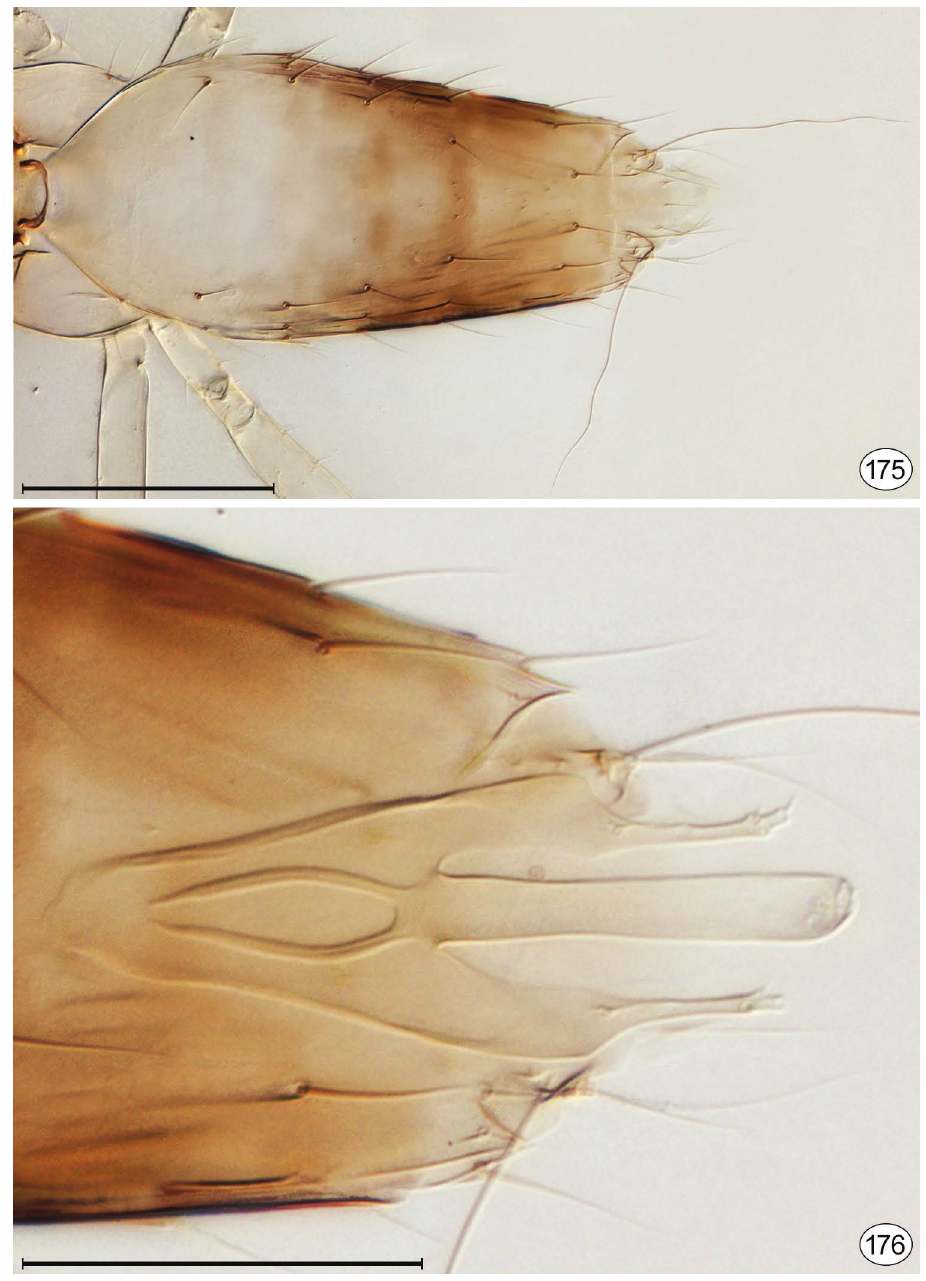
Figures 175, 176. Proarescon similis , male paratype. 175 metasoma, dorsal 176 genitalia, dorsal (seen through body). Scale bar for 175 = 100 μm; 176 = 50